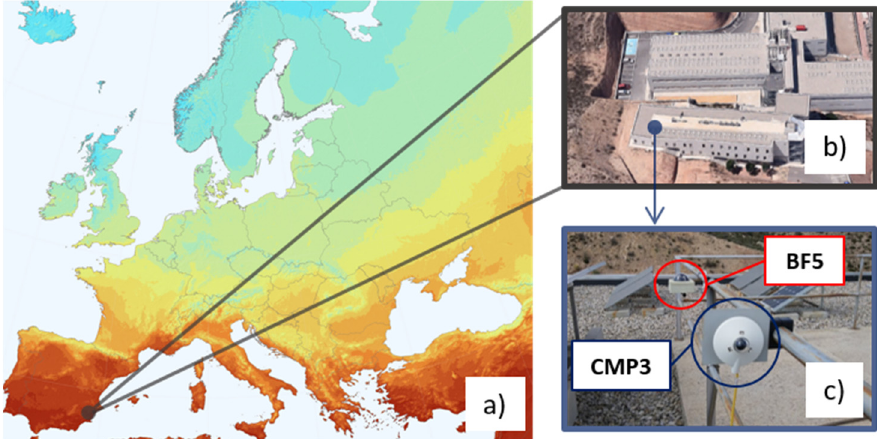
Figure 2. ( a ) Test location at coordinates 38.02347, − 1.17600; ( b ) Pyranometers placed on the gravel roof of a three-story building at University of Murcia; ( c ) Pyranometer with shadow band model Delta-T Device model BF5 to measure GHI and DHI, and Kipp&Zonen model CMP3 to measure global in-plane irradiance at different orientations.